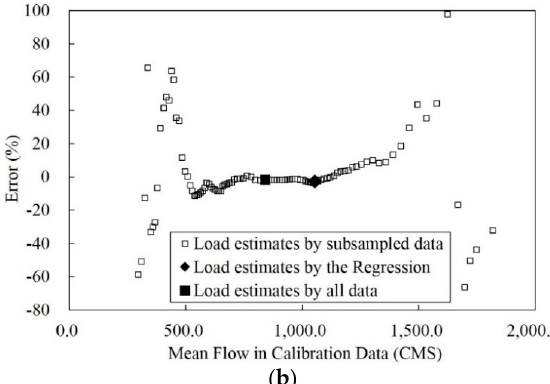
Figure 5. Annual sediment load estimates by MFCs: ( a ) USGS station number 02119400; ( b ) USGS station number 06486000. Table 4. Comparison of annual sediment load estimate errors between regression equation and all data.